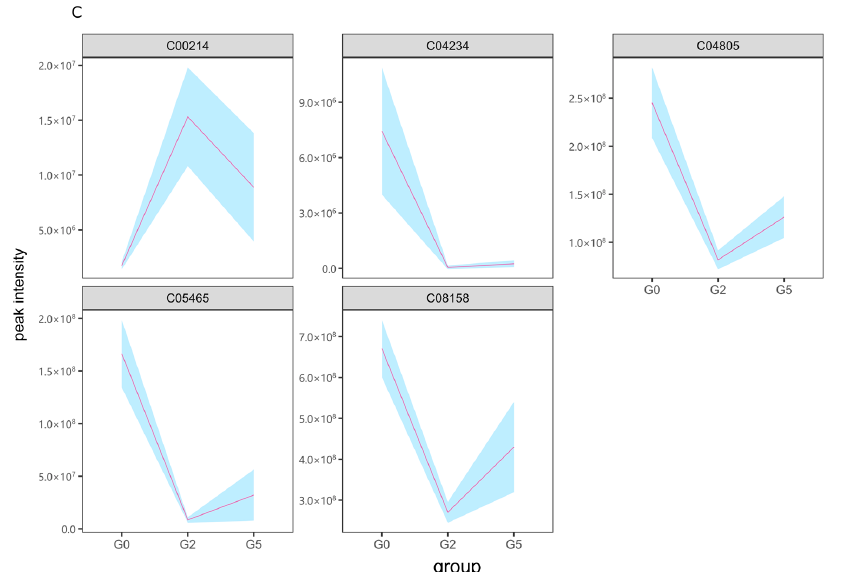
Figure 7. Differential metabolites induced by lotusine. ( A ) Volcano plot of the contrast G5/G2. ( B ) Numbers of changed metabolites compared with G2/G0. ( C ) Response metabolites with reverse changing trends when zebrafish were exposed to alcohol and lotusine. The light blue background represents the standard deviation range. Statistical p < 0.05; Fold Change > 1.5; G2/G0, G2 vs. G0, G5/G2, G5 vs. G2.